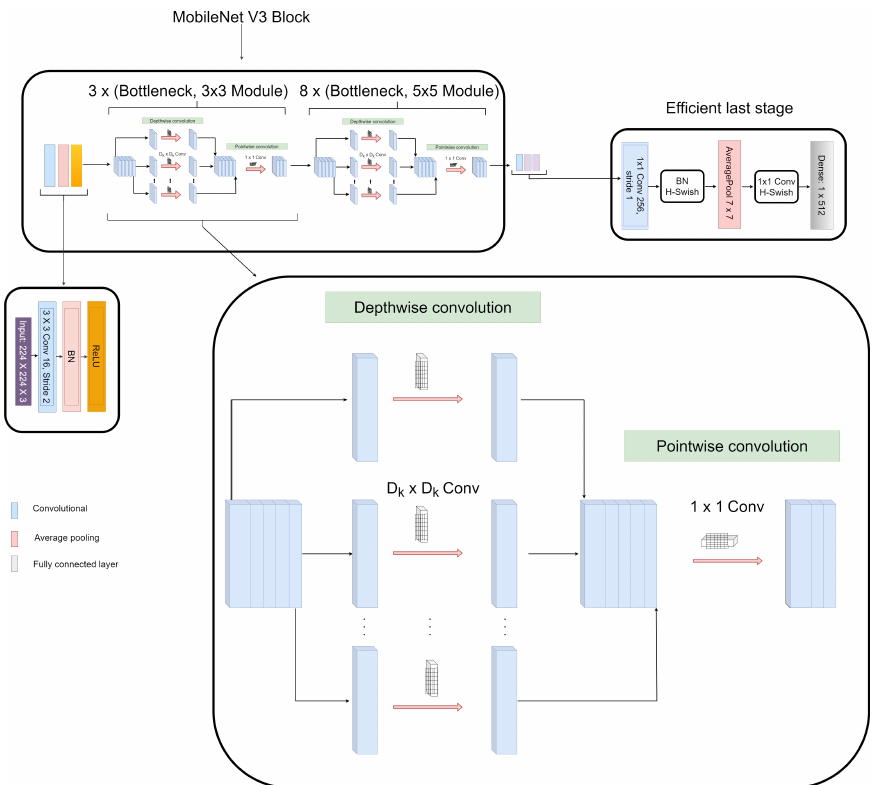
Figure 6. Framework of the pretrained MobileNet-V3 utilized for the features extraction of CECED CXR